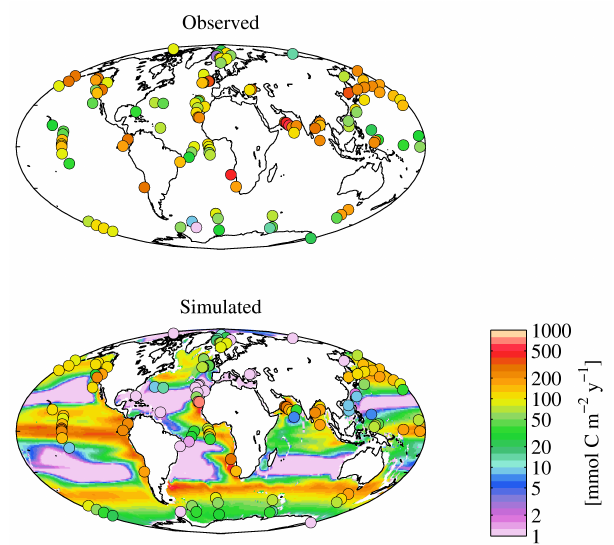
Fig. 36. Observed (top) and simulated (bottom) detrital sinking fluxes at 2000m. Observations drawn from Honjo et al. (2008). De- trital sinking flux in mmolCm − 2 y − 1 and shown here on a logarith- mic scale.